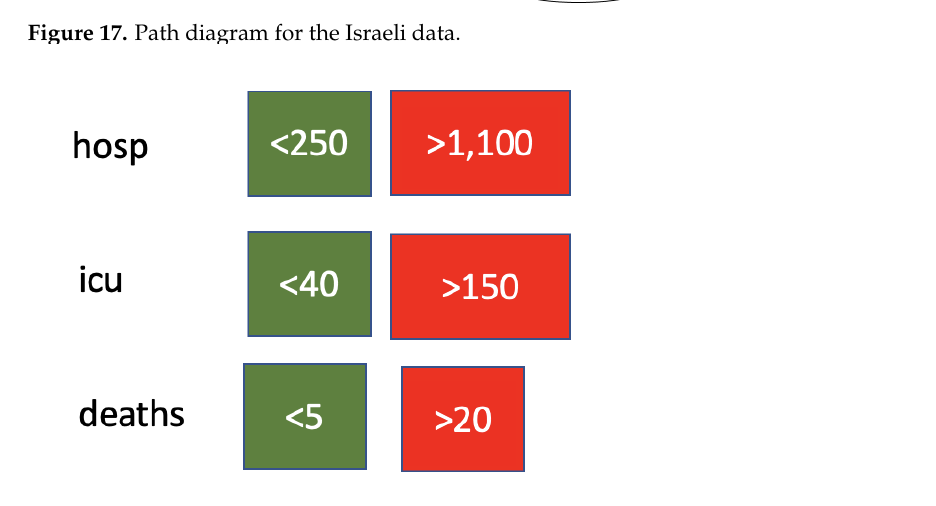
Figure 17. Path diagram for the Israeli data.